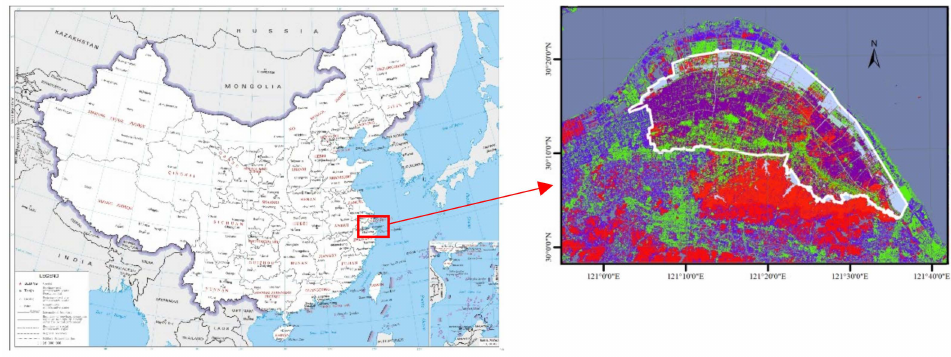
Figure 1. Location of research